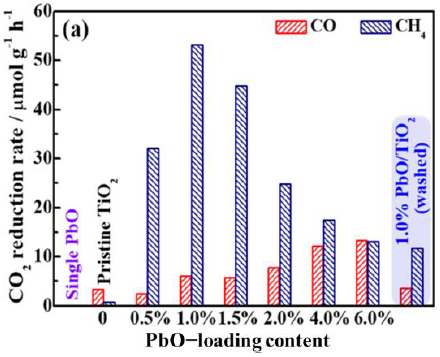
Figure 2. Photocatalytic CO/CH 4 production activities of the single PbO, pristine TiO 2 and PbO/TiO 2 composites. Reprinted with permission from Ref. [60]. 2020 Jin, J.; Chen, S.; Wang, J.; Chen, C.; Peng, T.